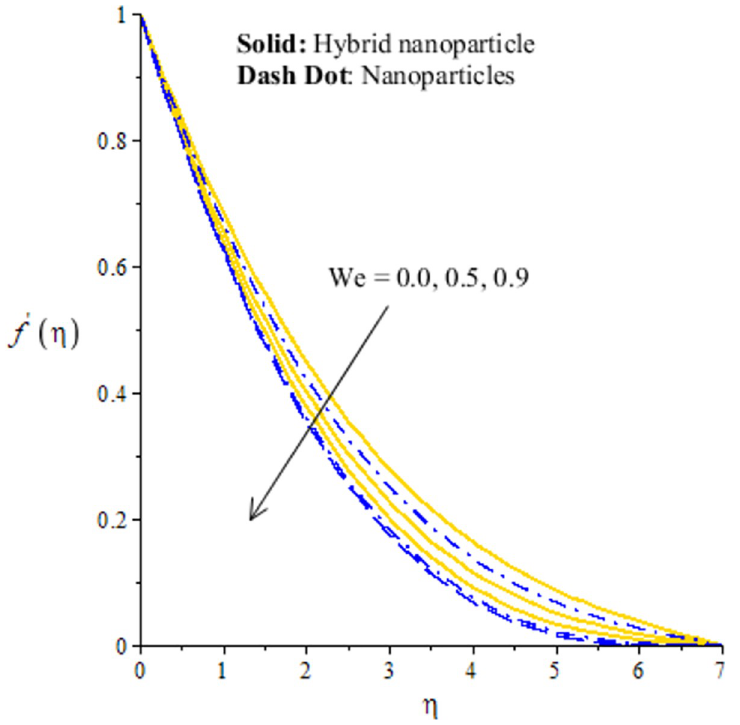
Fig 3. Distribution of velocity versus we